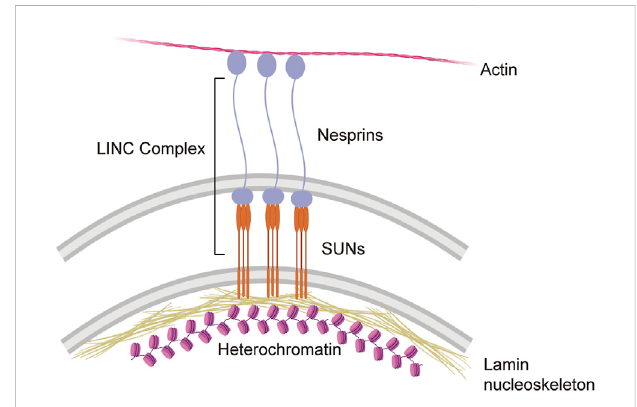
FIGURE 1 The LINC complex and its direct interactions with the cyto- and